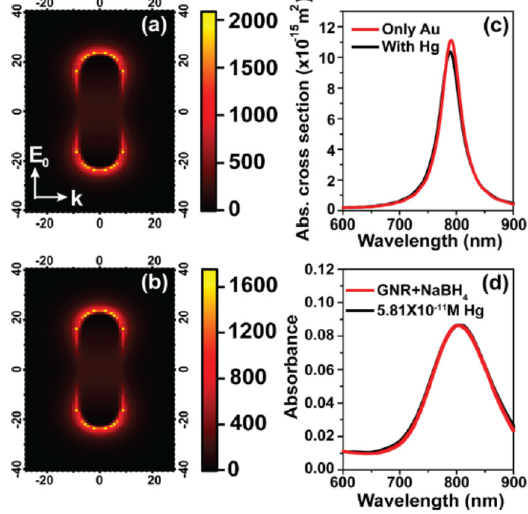
Figure 8. Electric field enhancement in the absence ( a ) and presence ( b ) of mercury; simulated ( c ) and experimental LSPR spectra ( d ) for comparison. Republished with permission from [94]; permission conveyed through Copyright Clearance Center, Inc.